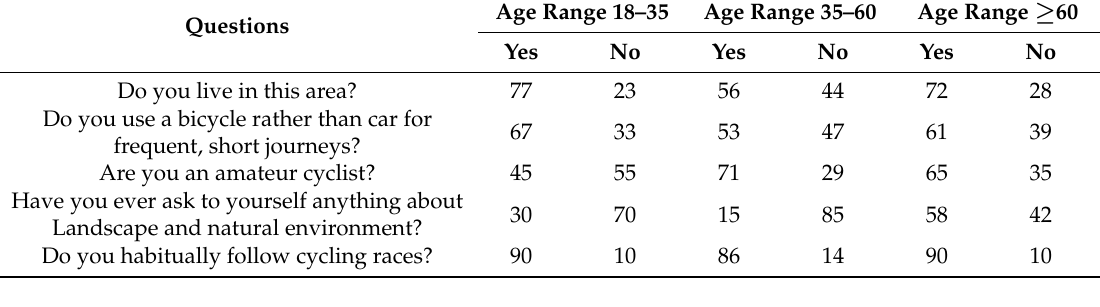
Table 1. Table of personal involvement in cycling and environment.